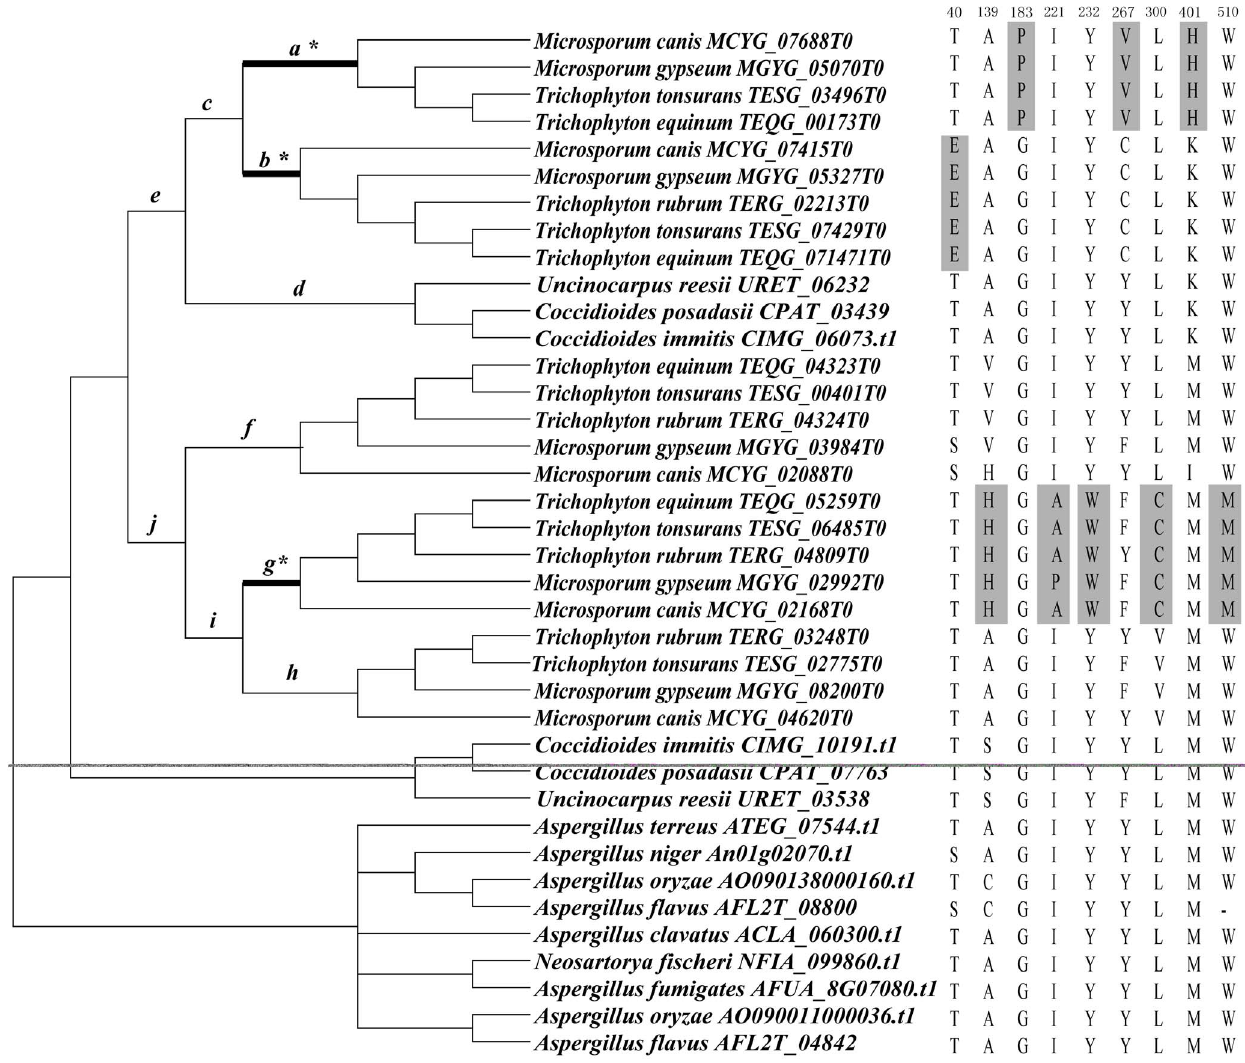
Figure 6. Phylogenetic tree of 38 M36 family genes used for codon-based maximum likelihood analysis in PAML. Phylogenetic trees were collapsed with inconsistent nodes from different tree-building methods and poor statistical supports into polytomy. Branches a-j indicated putative duplication events in Onygenales fungi. The branches with significant evidence of positive selection are indicated as a thick branch. The putative positively selected residues along these branches were shaded in grey.